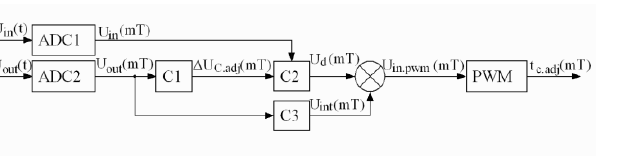
Figure 5. The functional diagram of the buck converter